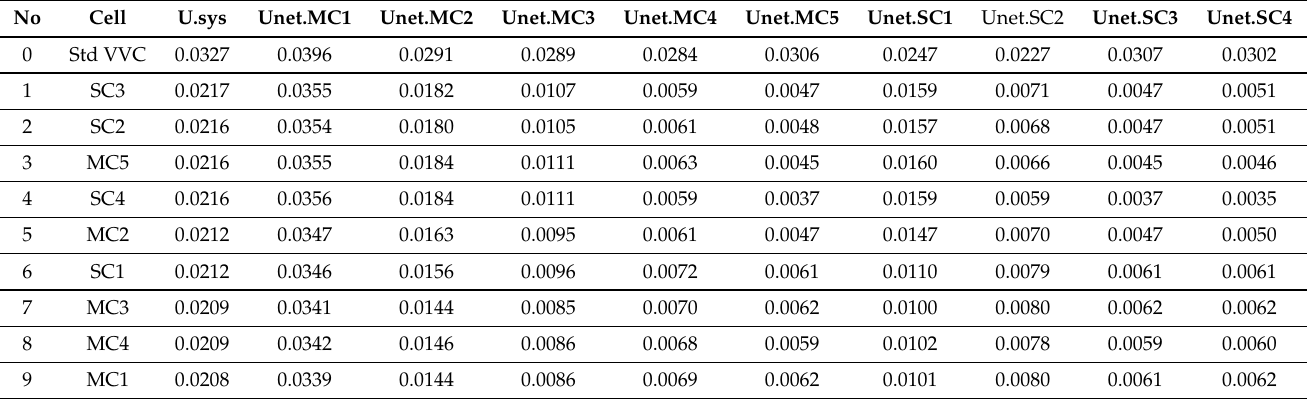
Table A5. Impact factor based priority based CCN: calculated utility function values for system and